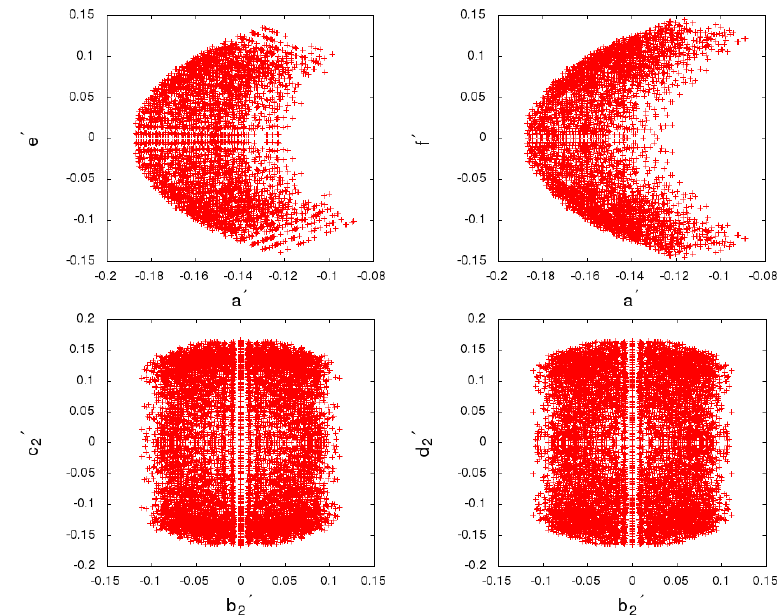
Figure 4 . Case-II: plots of the primed parameters for a normal mass